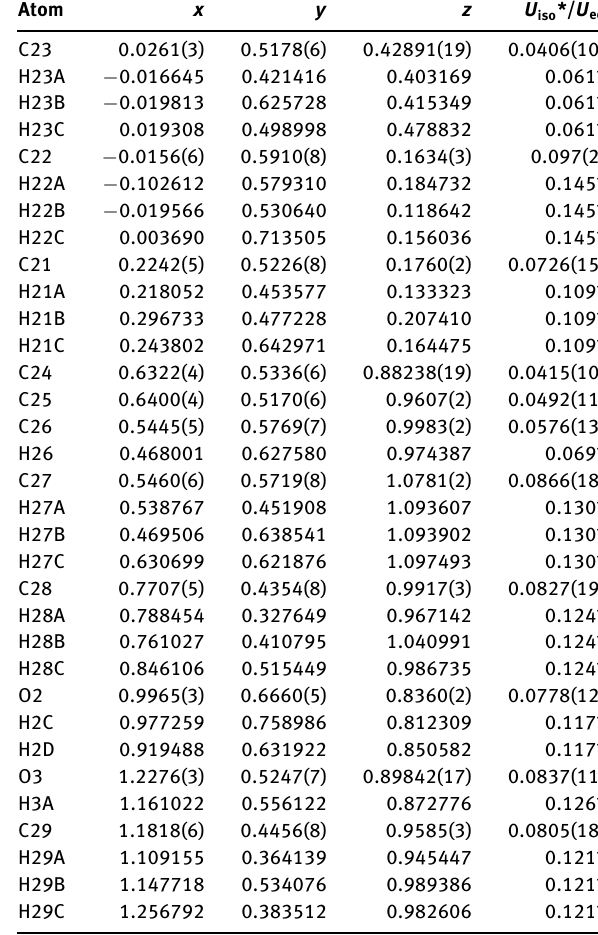
Table 2: Fractional atomic coordinates and isotropic or equivalent isotropic displacement parameters (Å 2